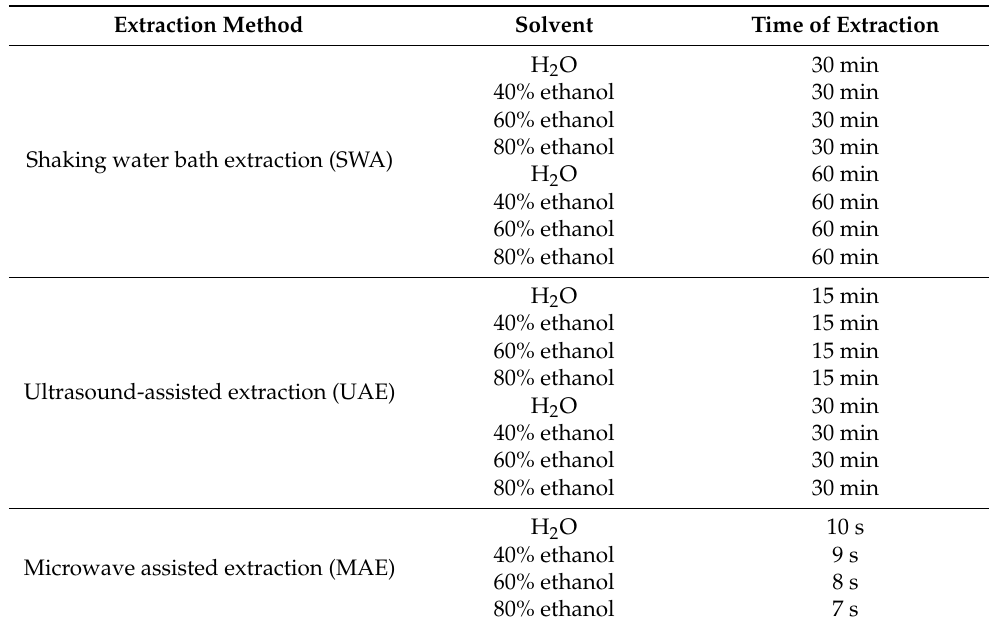
Table 3. Variants of the extraction of bioactive compounds from P. barbatus ( Coleus forskohlii ) roots with extraction